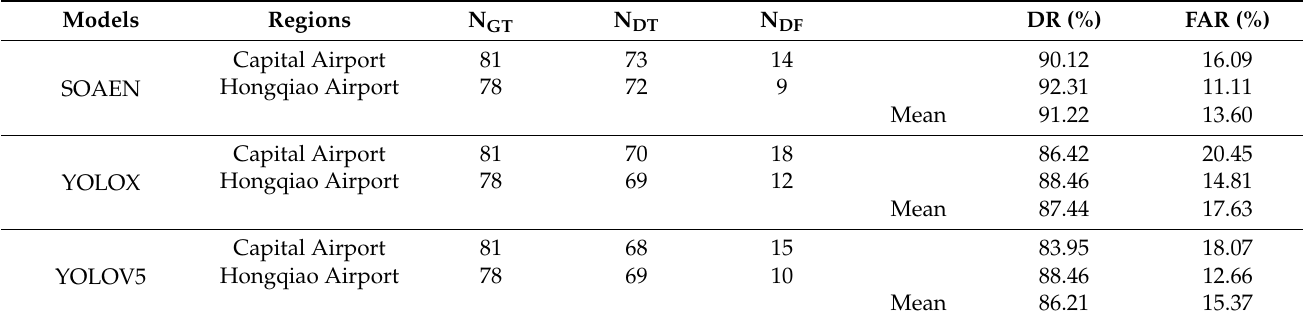
Table 3. Comparison of test performance between different